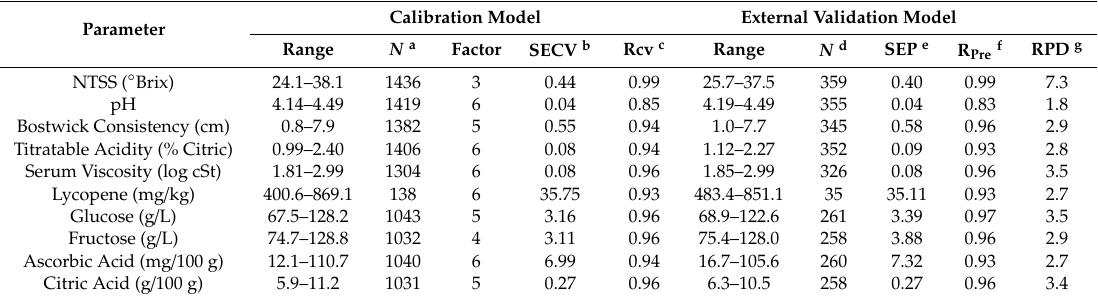
coefficient of cross-validation. d Number of samples used in external validation models. e Standard Table 2. Statistical performances of the partial least square regression (PLSR) models developed. error of prediction. f Correlation coefficient of prediction for validation. g Residual predictive deviation. Standard error of cross-validation (SECV) and standard error of prediction (SEP) are in Parameter units of the predicted parameters.